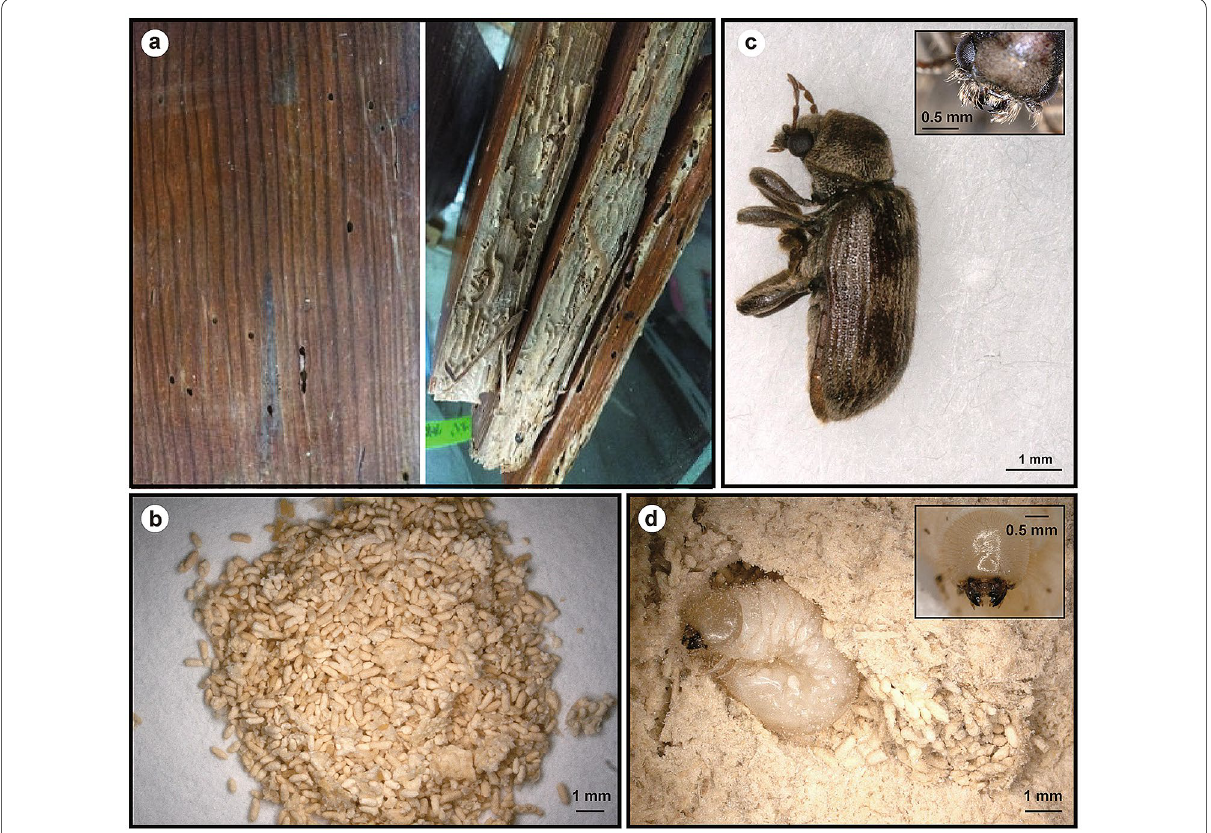
Fig. 1 Damage caused by Nicobium hirtum and appearance of adults and larvae. Appearance of wooden furniture attacked by N. hirtum ( a ), cylindrical larval fecal pellets ( b ), and morphology of N. hirtum adult beetle ( c ) and larva ( d ). Inserts are magnified facial views showing toothed mandibles of N. hirtum adult beetle ( c ) and larva ( d